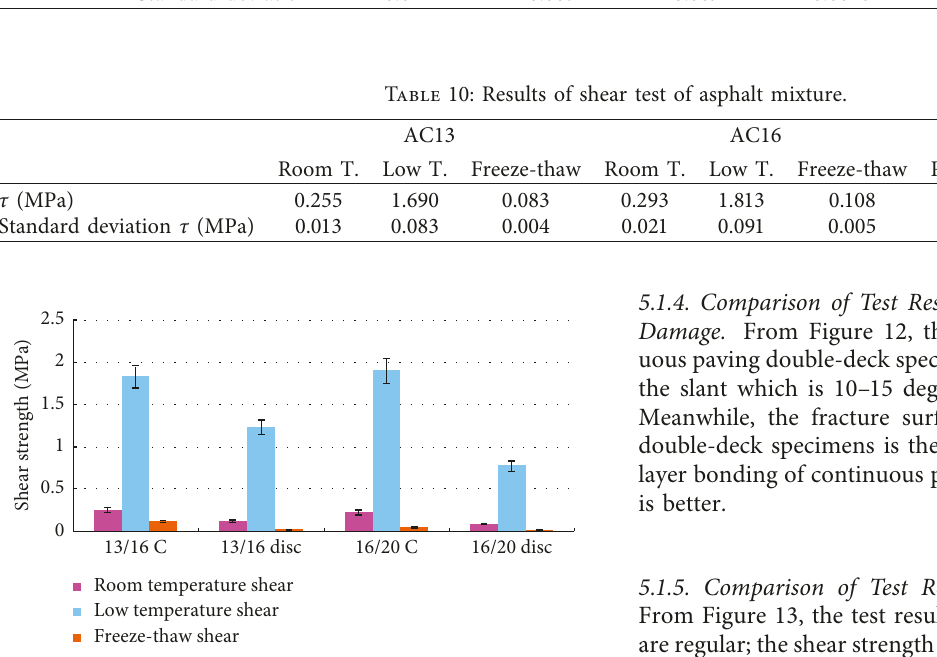
Figure 10: Comparison of test results from